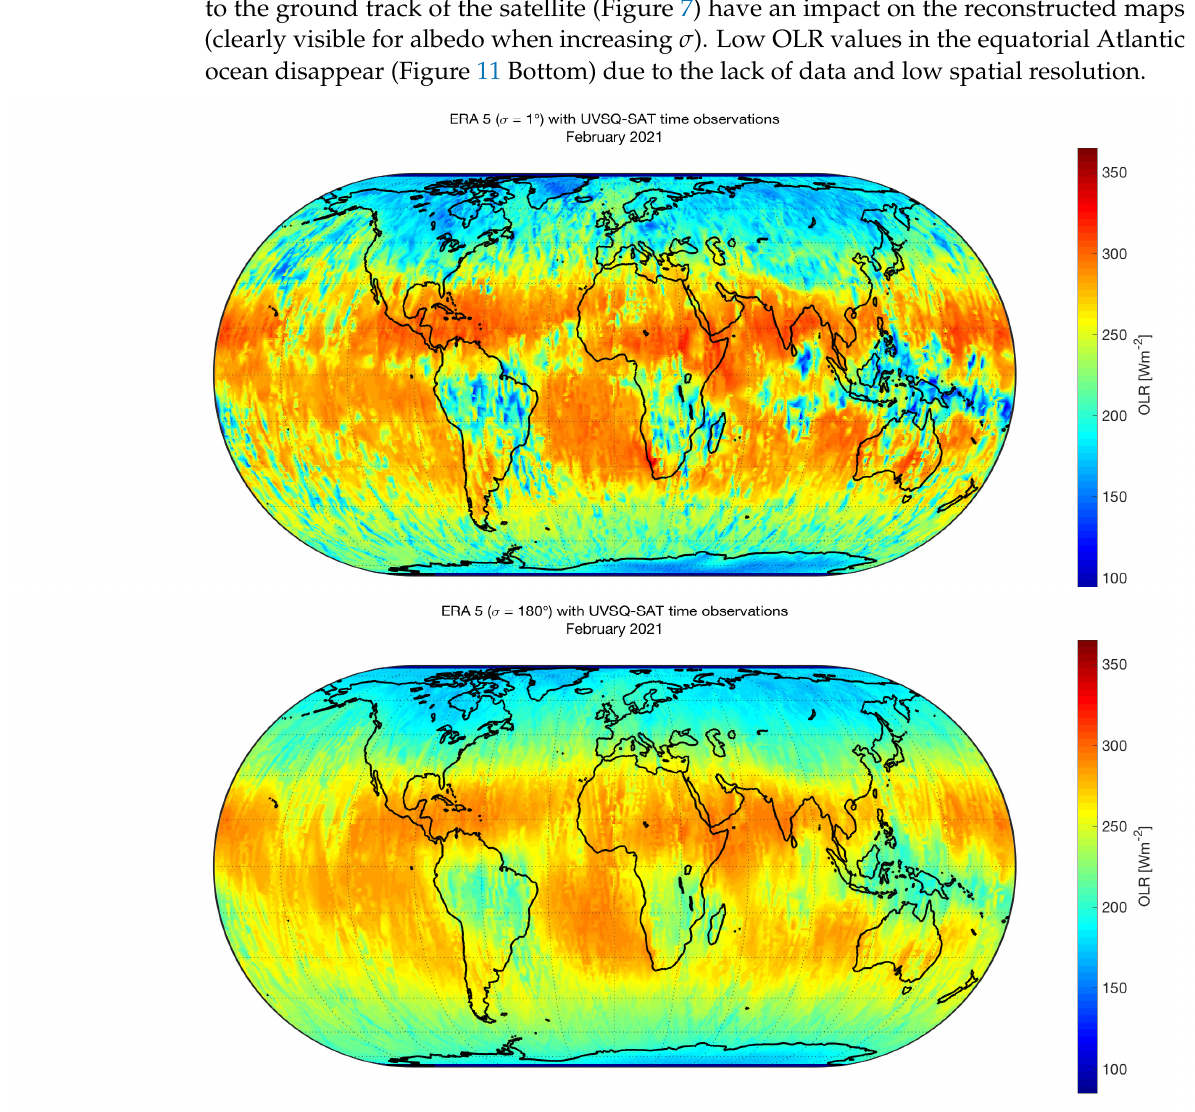
Figure 11. ( Top ) OLR (ERA5) during the month of February 2021 from same observation than UVSQ-SAT ( σ = 1 ◦ ). ( Bottom ) OLR (ERA5) from same observation than UVSQ-SAT ( σ = 180 ◦